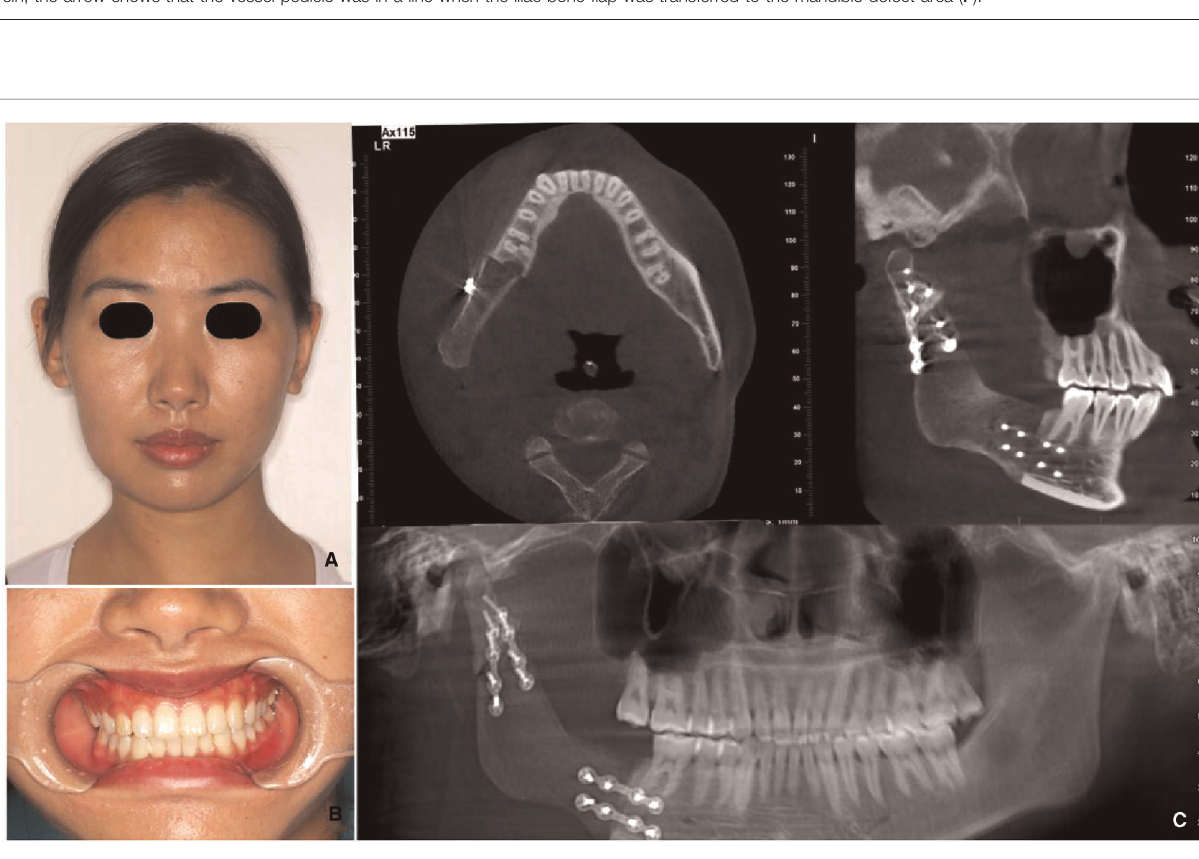
Frontiers in Surgery |